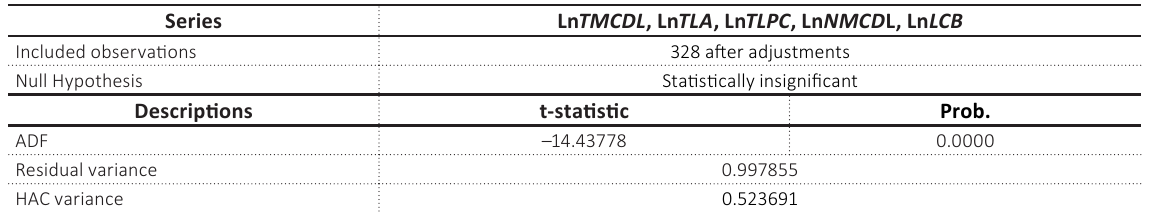
Table 7. Co-integrating test, as suggested by Kao